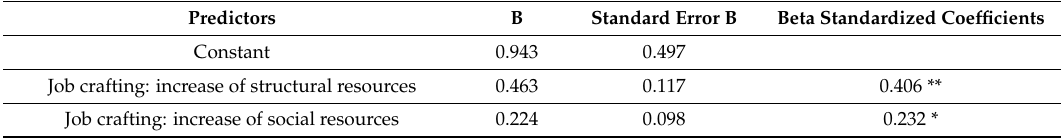
Table 4. Linear regression analysis on job